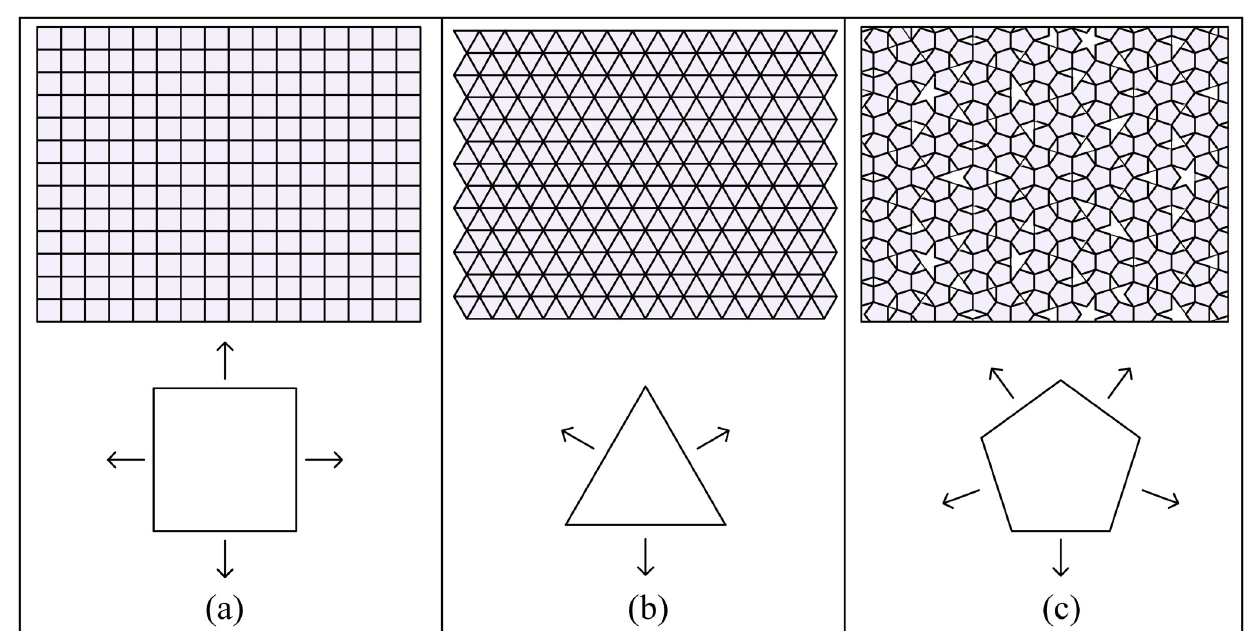
Fig 2. Direction of grids. Three different patterns of grid of the plane for the Platonic solids. (a) A square grid for the cube with 4 edge-rolling directions. (b) A triangular grid for the tetrahedron, octahedron, and icosahedron with 3 edge-rolling directions. (c) A pentagon grid using Penrose tiling for the dodecahedron with 5 edge-rolling